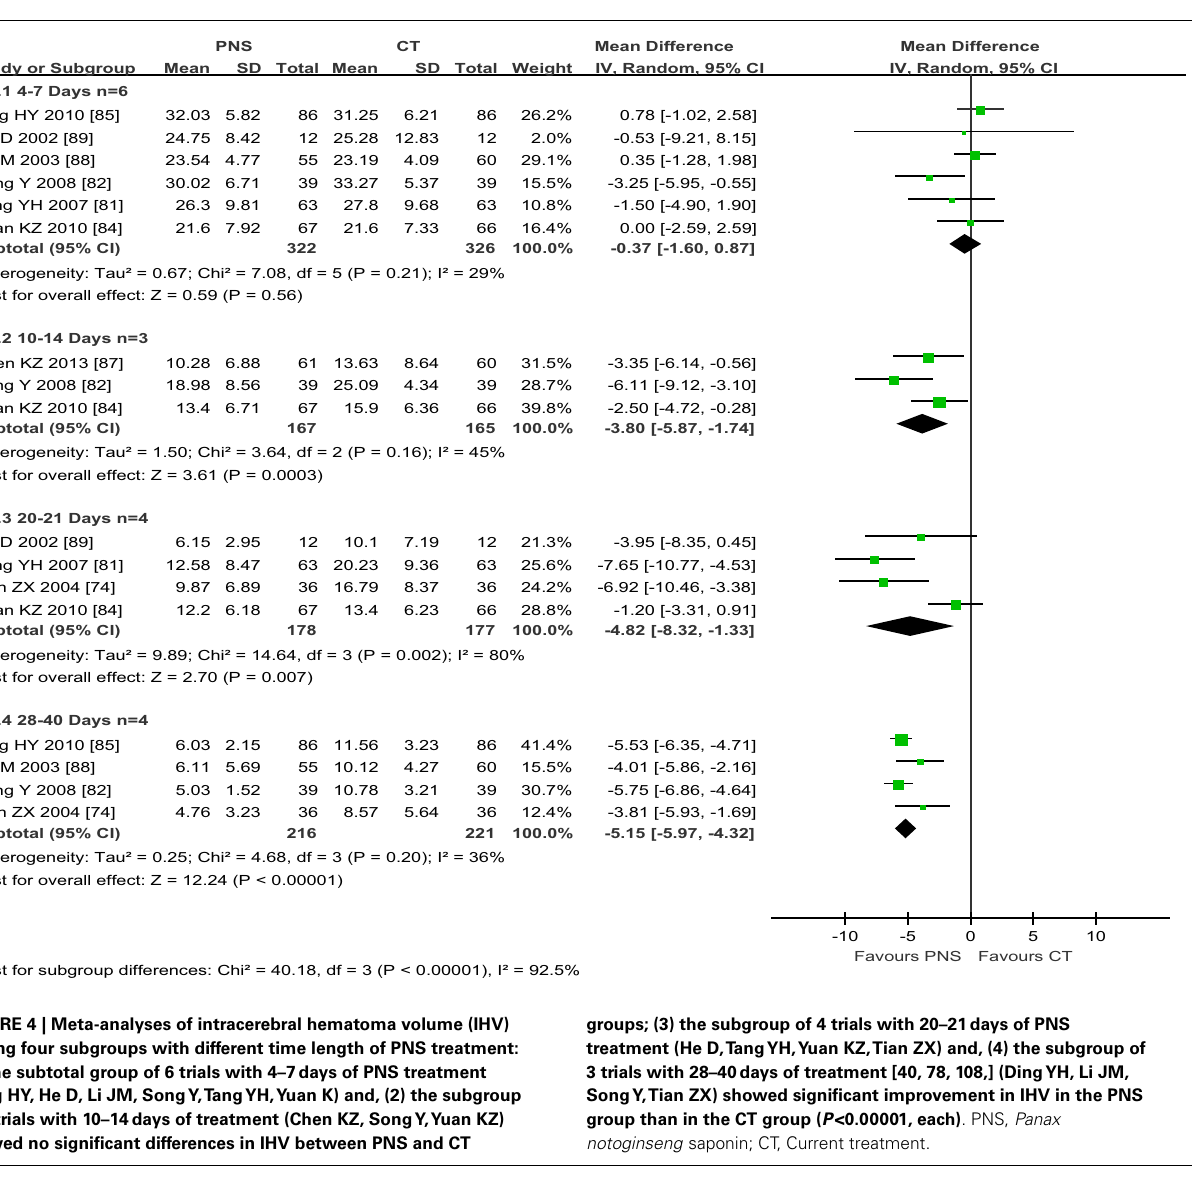
Test for overall effect: Z = 3.61 (P = 0.0003)